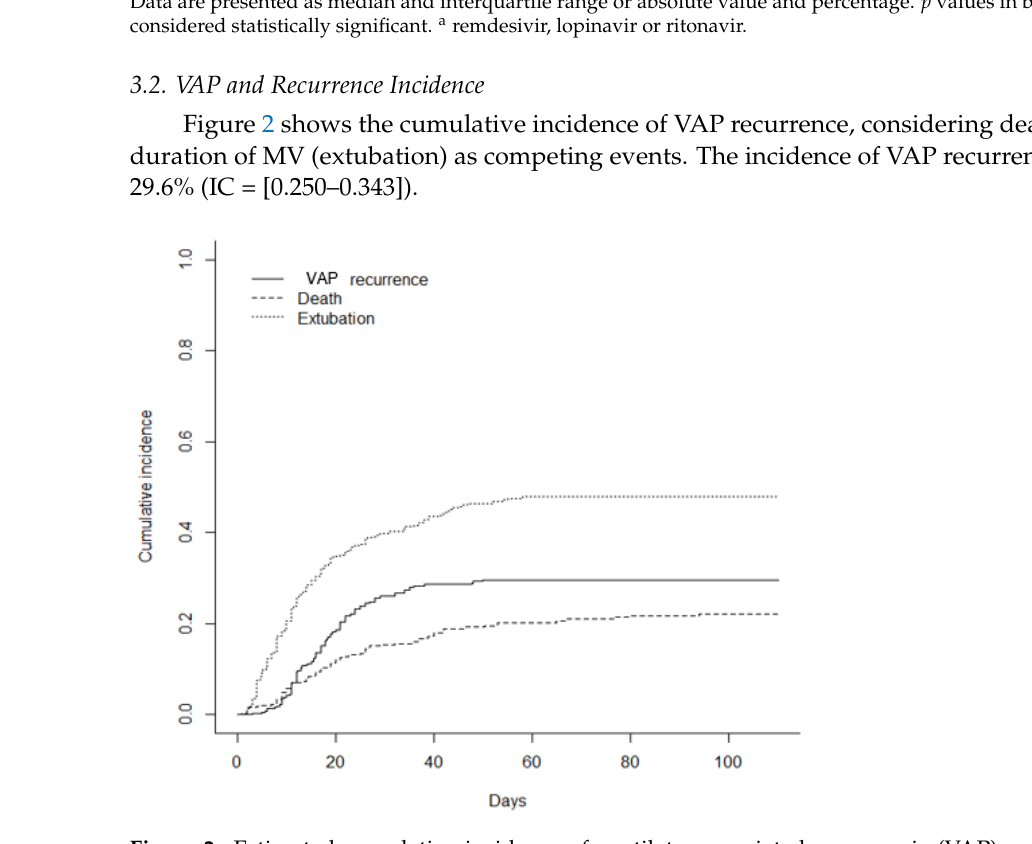
Figure 2. Estimated cumulative incidence of ventilator-associated pneumonia (VAP) recurrence considering death and extubation as competing events. VAP: ventilator-associated pneumonia.